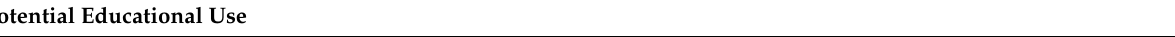
Table 1. Assessment of potential educational use of the Jozef adit according to Brilha